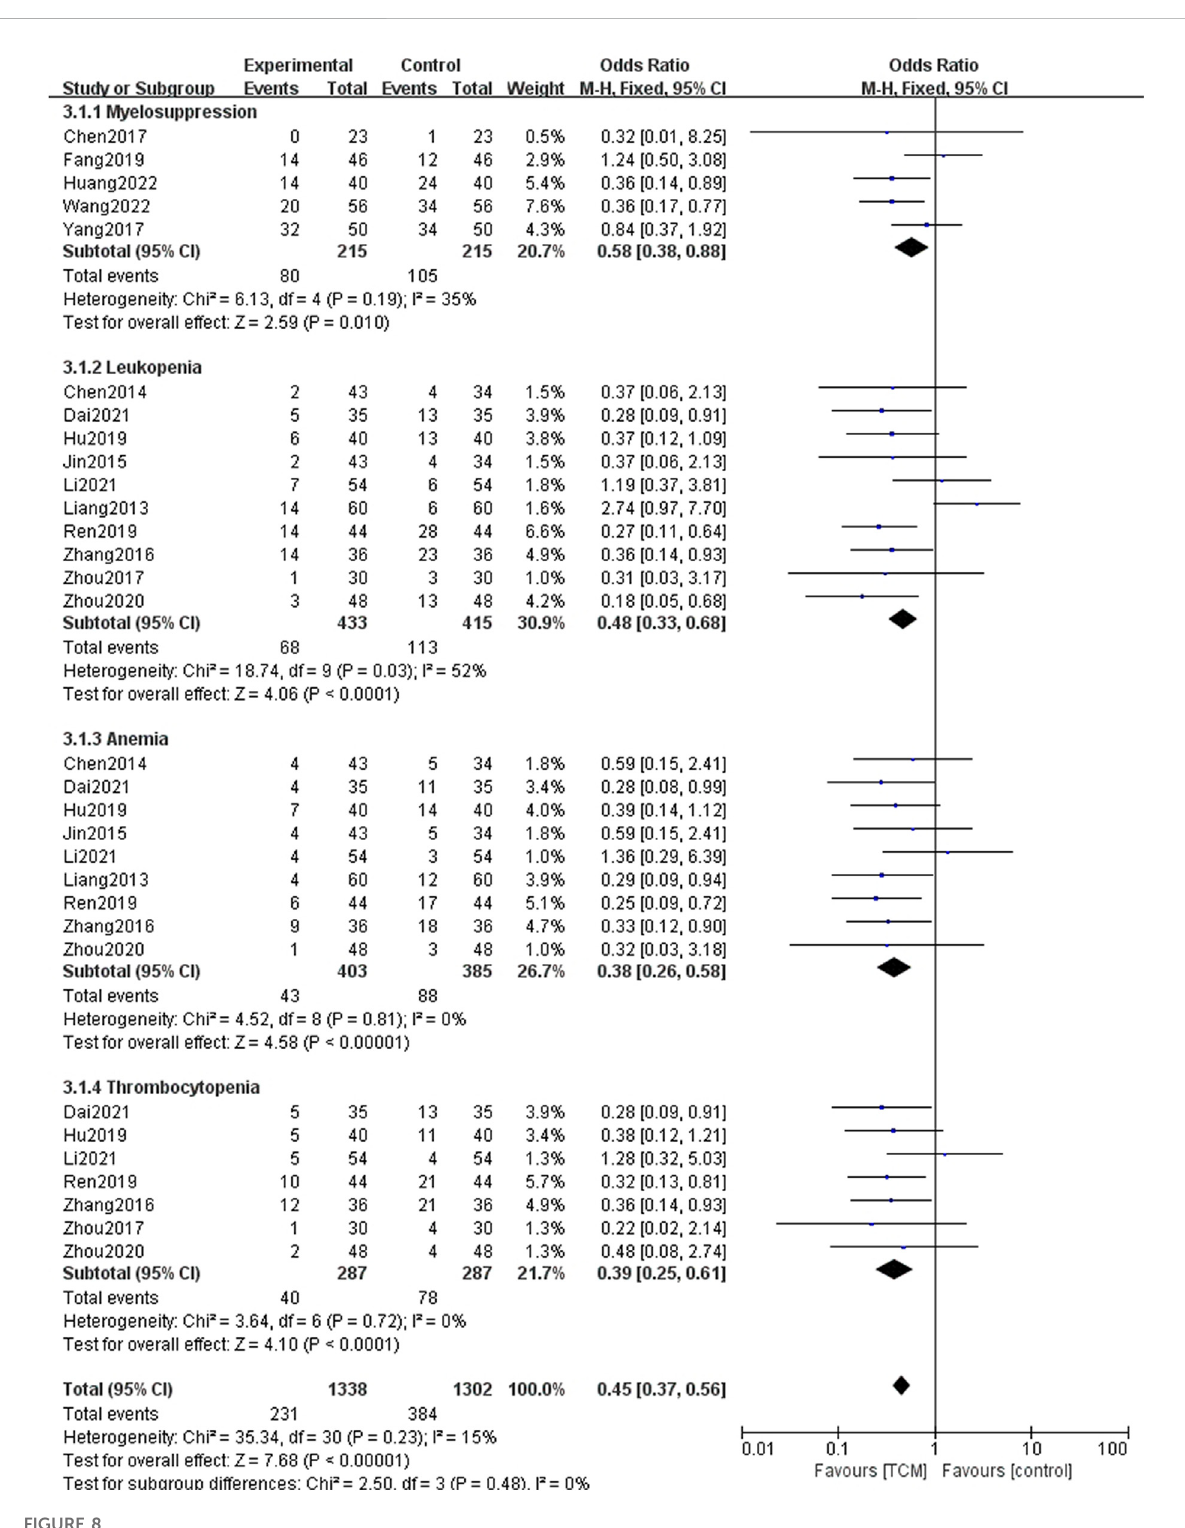
FIGURE 8 Forest plots and subgroup analysis for myelosuppression